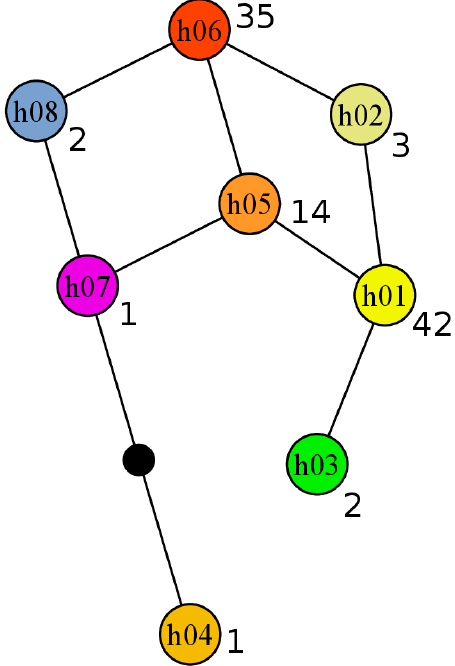
Figure 2. Minimum spanning network of the cpSSR haplotypes. Each line denotes a mutation step. The numbers refer to the absolute frequency of each haplotype in the study area.